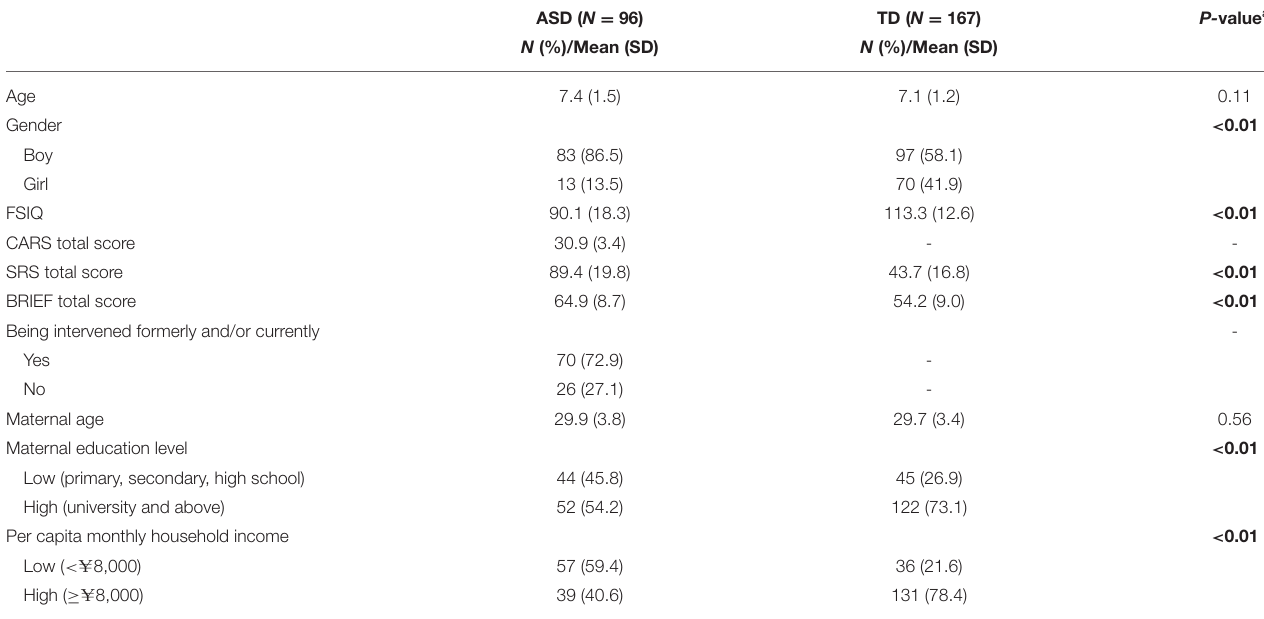
TABLE 1 | Demographic and Clinical characteristics of autistic children and TD